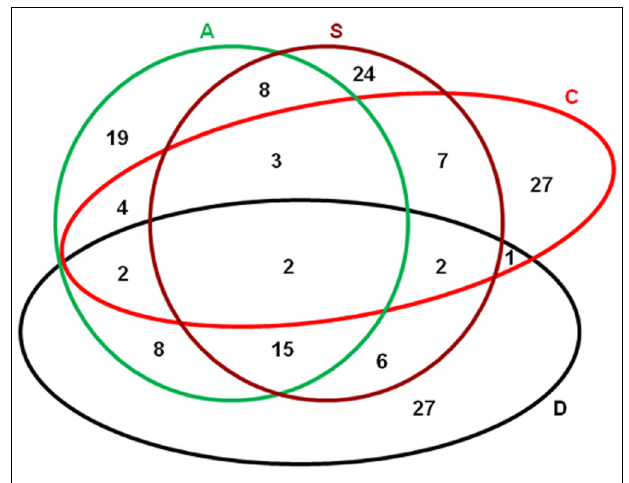
FIGURE 1 |Venn map showing the proteins that were regulated by different abiotic stresses andABA treatments. D, desiccation treatment: dehydrating to 90% fresh weight loss; S, salt treatment: > 0.25 M NaCl for 3 days; C, cold treatment: 0 ◦ C incubation for > 1 day; A, 50 μ M ABA treat for 3 days.The raw data for this figure were from our previous studies (Wang etal., 2008, 2009a,b, 2010).